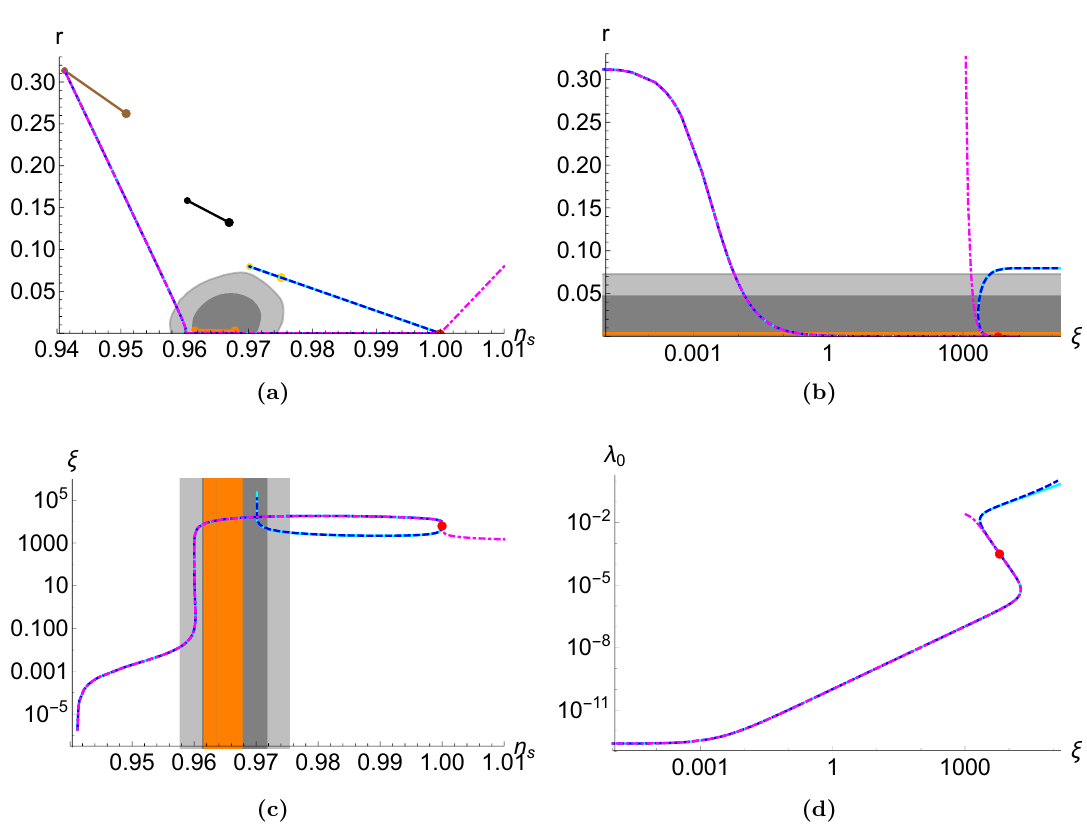
Figure 3 . Palatini formulation: r vs. n s (a), r vs. ξ (b), ξ vs. n s (c) and λ 0 vs. ξ (d) for λ eff = λ app (cyan), λ eff = λ I (blue, dashed) and λ eff = λ II (magenta, dot-dashed) with N e = 50 e -folds. The red point indicates the loss of accuracy of the present analysis. For reference we also plot predictions of quartic (brown), quadratic (black) and linear (yellow) inflation for N e ∈ [50 , 60] . The gray areas represent the 1 , 2 σ allowed regions coming from Planck 2018 data [9].